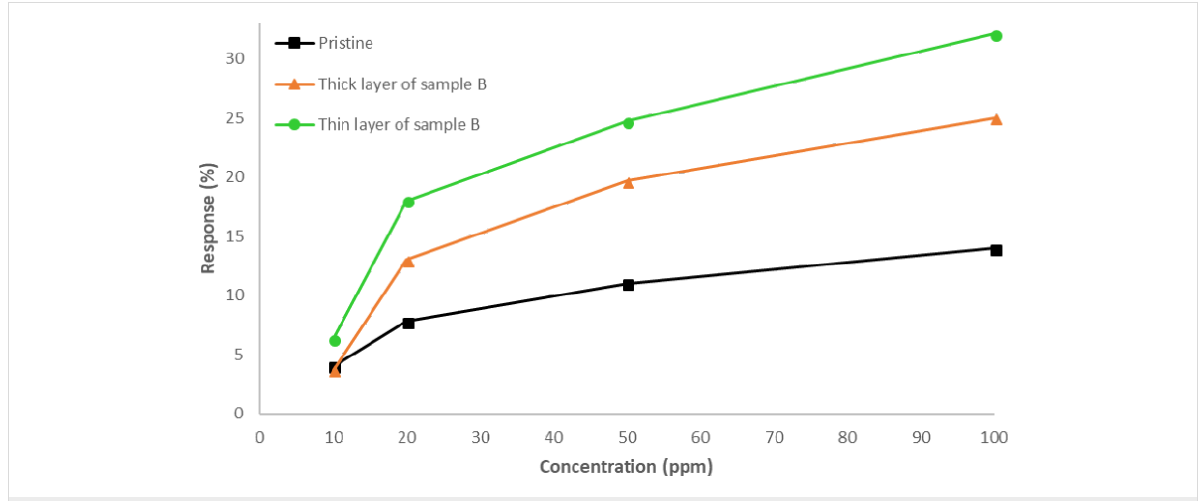
Figure 11: Effect of layer homogeneity and thickness on the gas sensing performance.